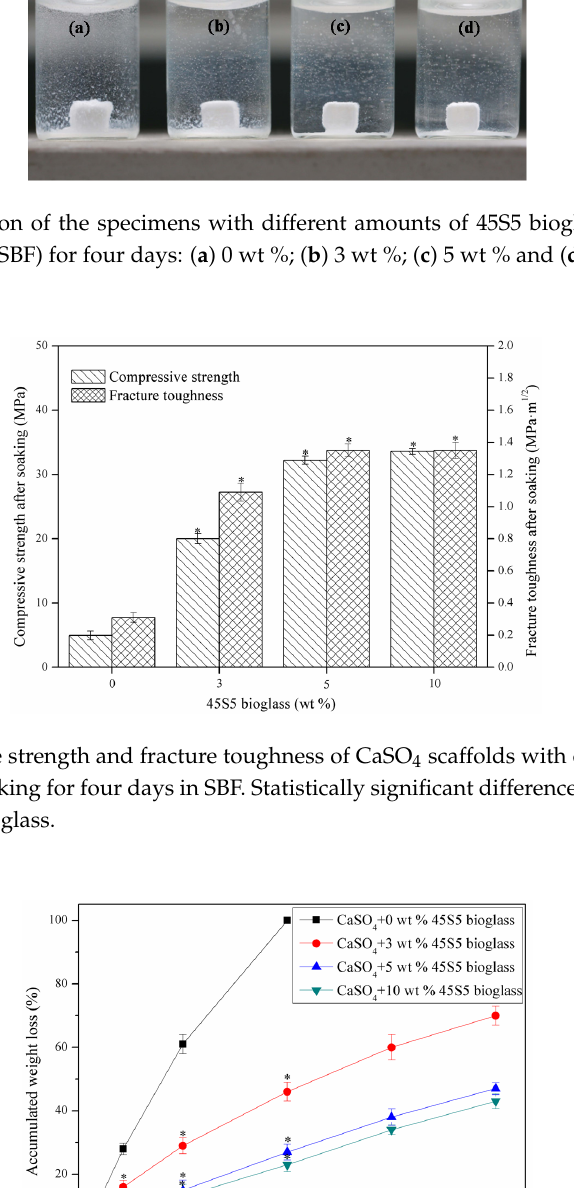
Figure 4. Compressive strength and fracture toughness of CaSO 4 scaffolds with different amounts of 45S5 bioglass. Statistically significant difference (* p < 0.05) from scaffolds without bioglass. 2.3. Stability The effect of 45S5 bioglass on the disintegration behaviour of the specimens is qualitatively shown in Figure 5. The specimens without 45S5 bioglass began to disintegrate when they were kept in the SBF for four days (Figure 5a). In contrast, only a few separated particles were observed in the surrounding solution of the specimens with 3 wt % 45S5 bioglass (Figure 5b). As the amount increased to 5 or 10 wt %, the specimens could retain their initial shape (Figure 5c,d). Compressive strength and fracture toughness of the CaSO 4 specimens with different amounts of 45S5 bioglass after soaking for four days is shown in Figure 6. In comparison with the properties of the specimens before soaking (Figure 4), compressive strength and fracture toughness of the specimens without bioglass after soaking decreased significantly from 19.78–4.96 MPa and 1.07–0.31 MPa ∙ m 1/2 , respectively. However, the properties of specimens with 5 or 10 wt % bioglass showed no obvious change. It suggested that the glassy phase acted as a binder between CaSO 4 grains and could improve the stability of the specimens. This enhancement theory of stability was similar to that of gelatin enhancing calcium silicate by Wang et al. [25]. The accumulated weight loss of the specimens with different amounts of 45S5 bioglass after